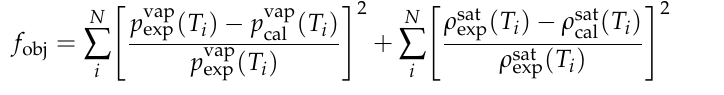
is the repulsive exponent; λ a is kk kk